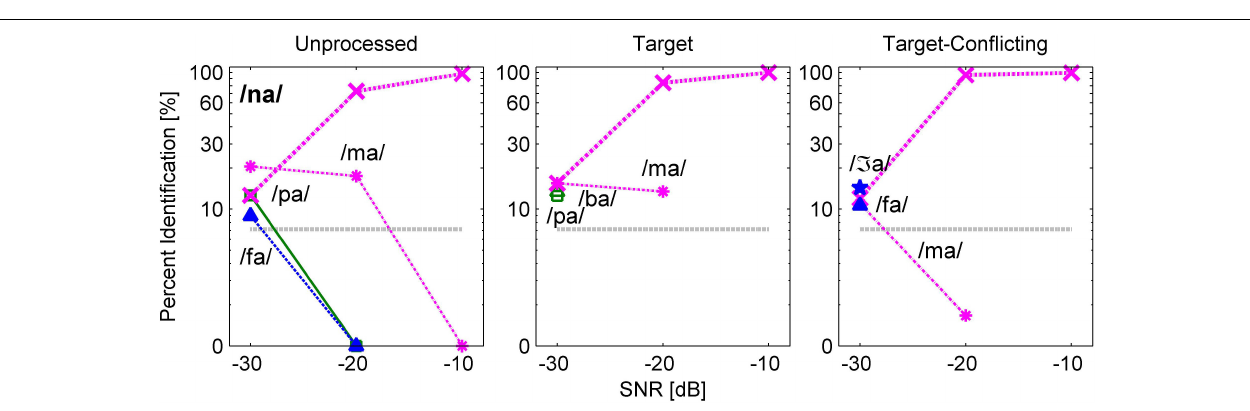
FIGURE 8 | Confusion patterns when /na/ was presented. A description for the figure is the same as presented in Figure 6